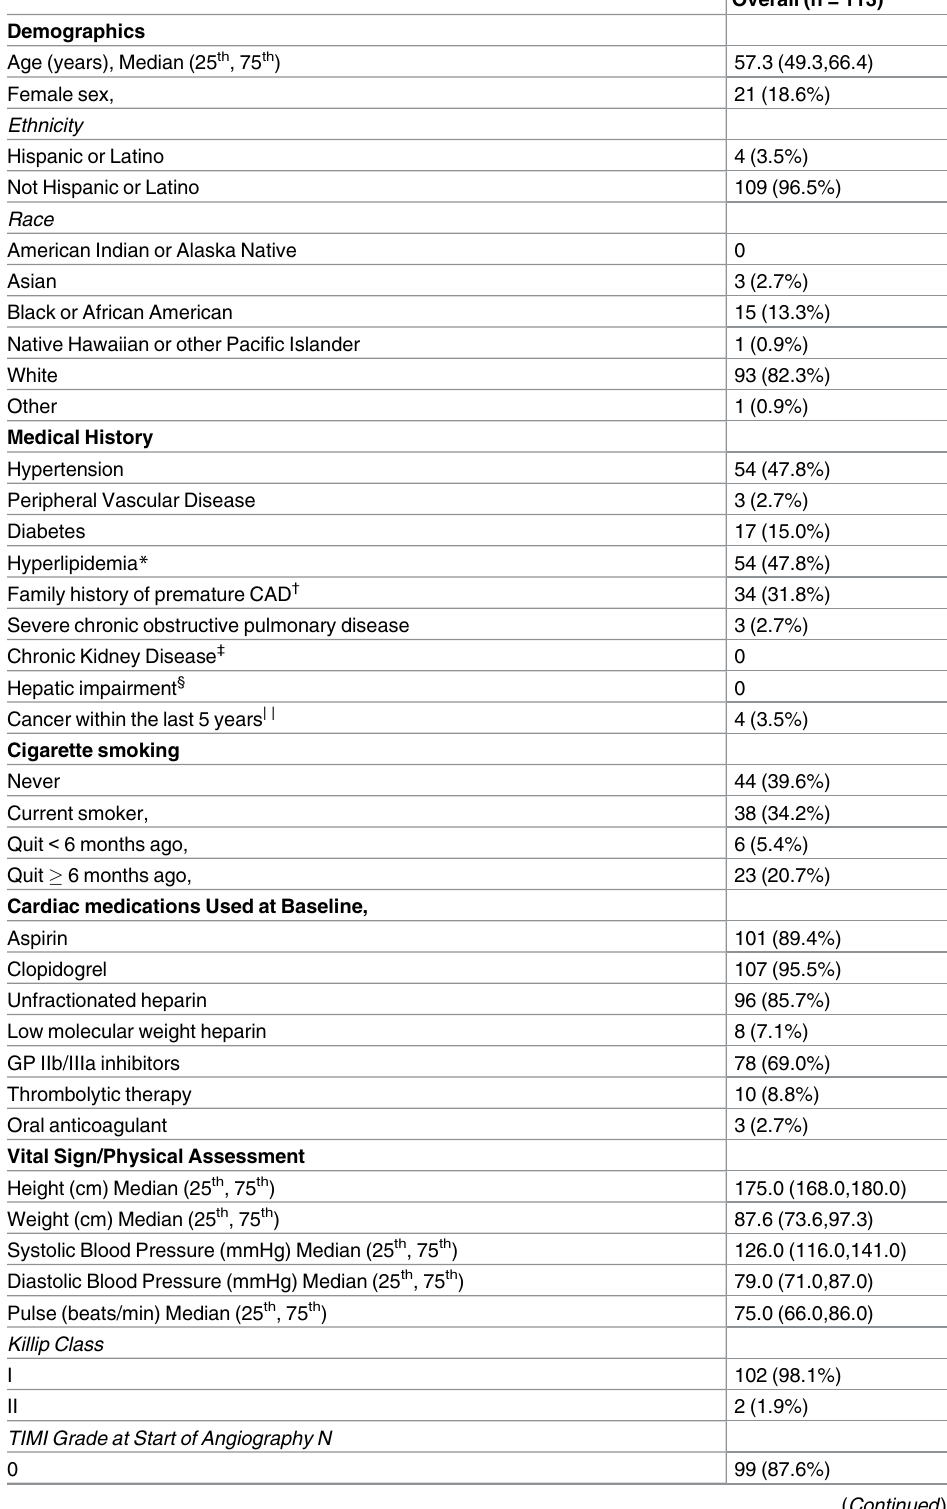
Table 1. Baseline Characteristics of